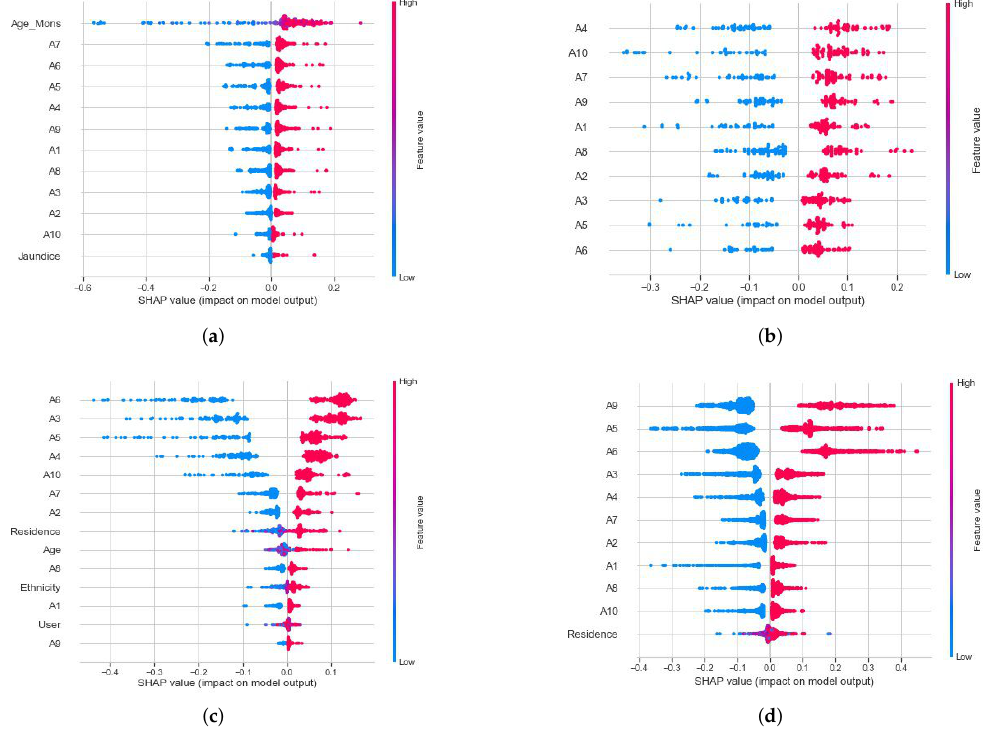
Figure 2. Analysis of Shapley values for ( a ) the toddler subset of the RIPPER method, ( b ) the adolescent subset of the Boruta algorithm, ( c ) the child subset of the CFS–Harmony Search method, and ( d ) the adult subset of the CFS method employing the best-performing